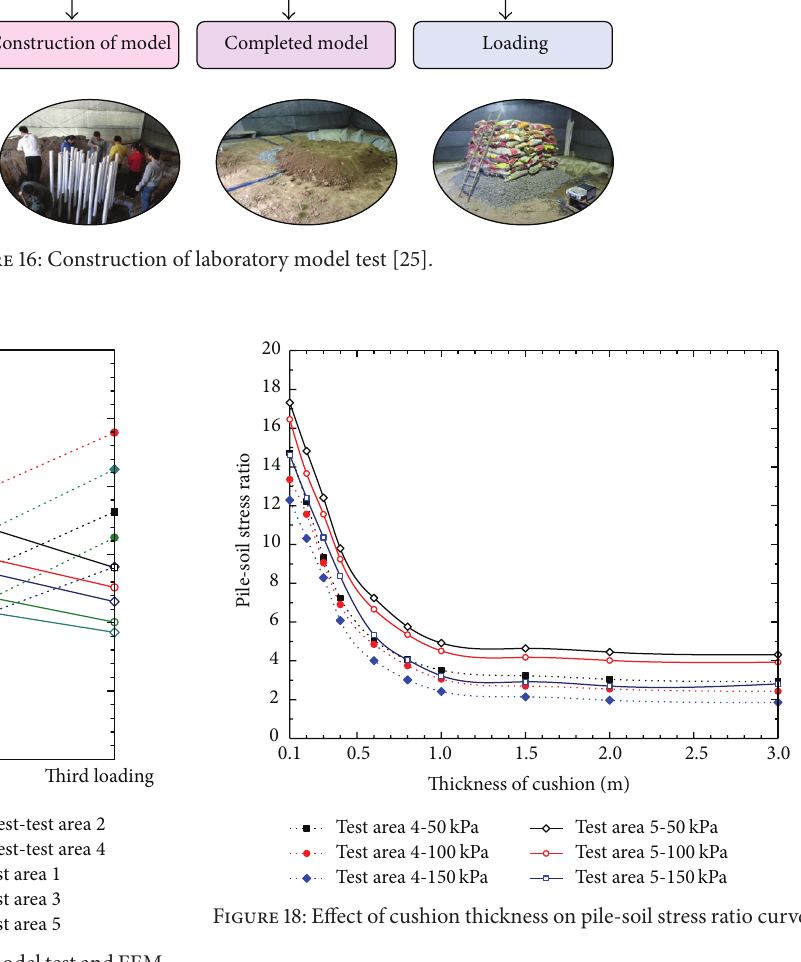
Figure 17: The results of pile-soil stress ratio in model test and FEM.